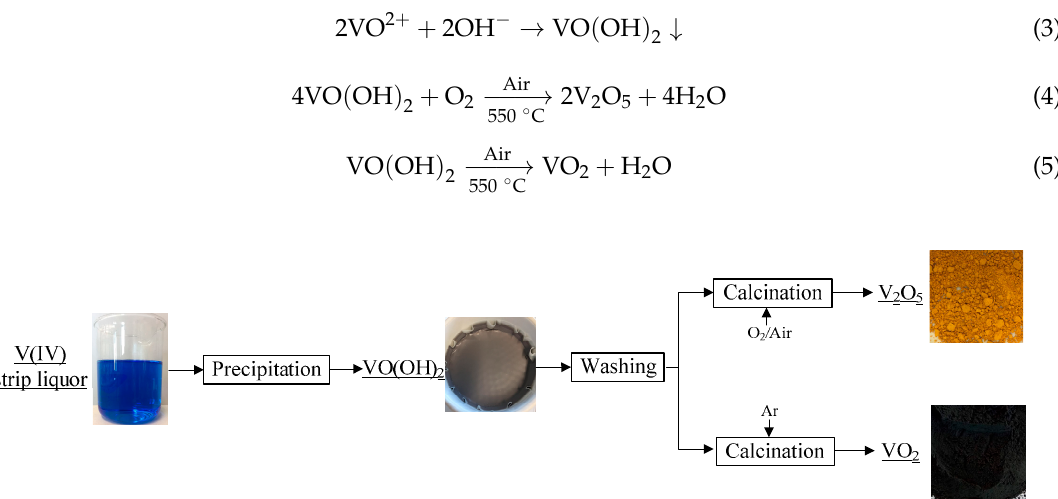
Figure 5. Proposed flowchart for preparation of vanadium oxides from the V(IV) strip liquor.